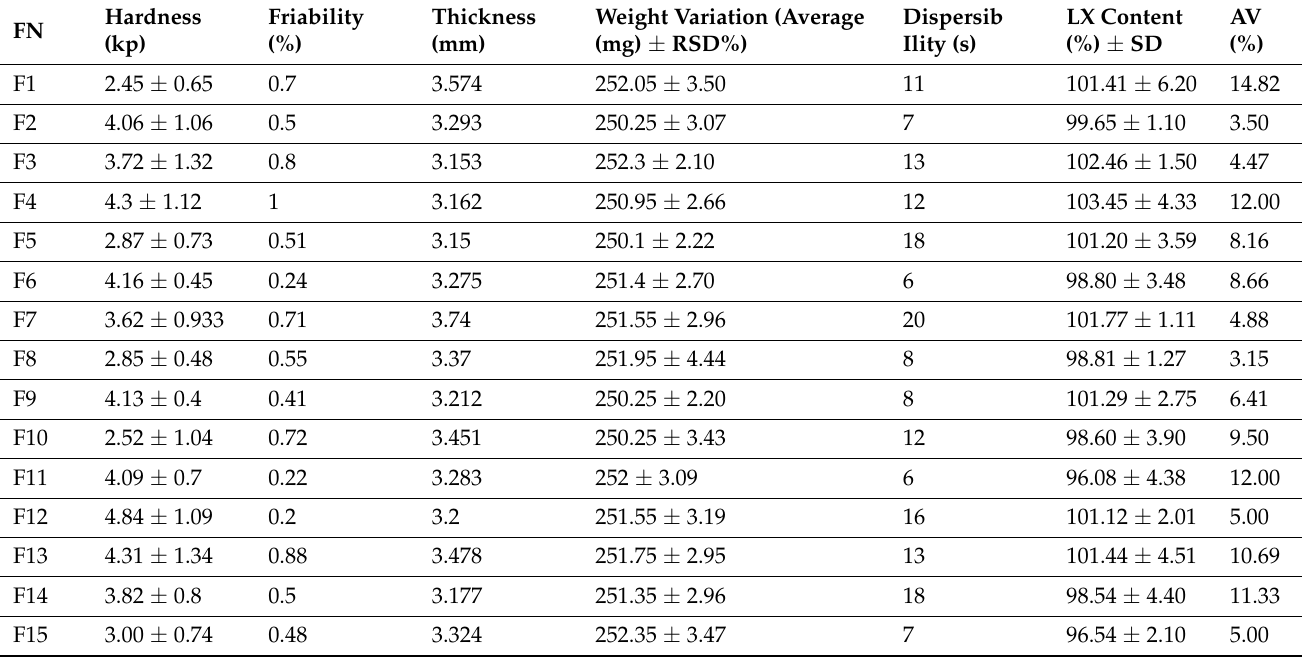
Table 2. Evaluation of LX DT